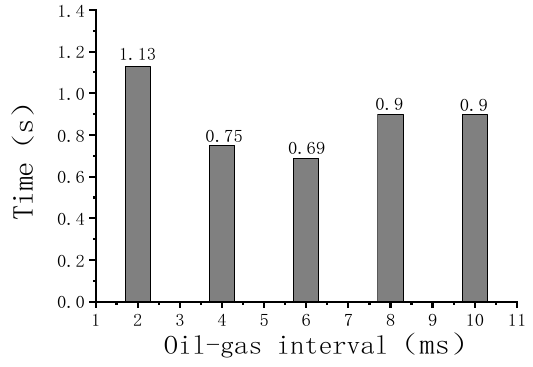
Figure 15. Rotation speeds for different oil–gas intervals during a cold start.